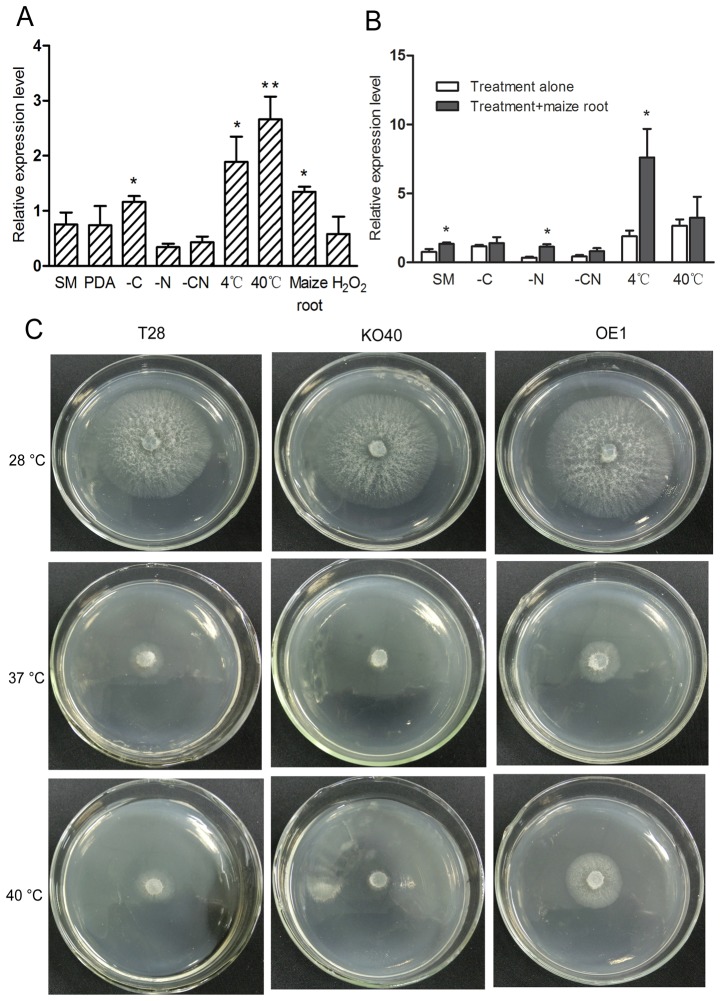
Quantitative real-time PCR shows PAF-AH mRNA expression levels.(A) Identical volumes (1×106) of spores were cultured in SM liquid medium for 72 h, and mycelia were washed once with sterile ddH2O, transferred to fresh medium, (100 mL), and grown with shaking at 180 rpm, at 28°C for 4 h unless otherwise stated below. The following conditions were tested: SM medium, PDA, SM medium without carbon source (-C), SM medium without nitrogen source (-N), SM medium without carbon and nitrogen sources (-CN), 4°C in SM medium, 40°C in SM medium, 1% maize root in SM, and 5 mM H2O2 in SM. (B) PAF-AH expression levels in SM, -C, -N, -CN at 4°C and 40°C or all above stress condition with 1% maize root induction. The actin gene was used as the internal control. The experiment was carried out in three biological repeats. * indicated a significant difference compared with SM medium (Student's t-test, P≤0.05), and * * indicated P≤0.01. Results shown are means ± SD (n = 3). (C) Different strains grew on SM plate agar at different temperatures. The photograph was taken after 24 h incubation at each temperature. T28, wild type; KO40, PAF-AH knockout transformant; OE1, PAF-AH over-expression transformant.